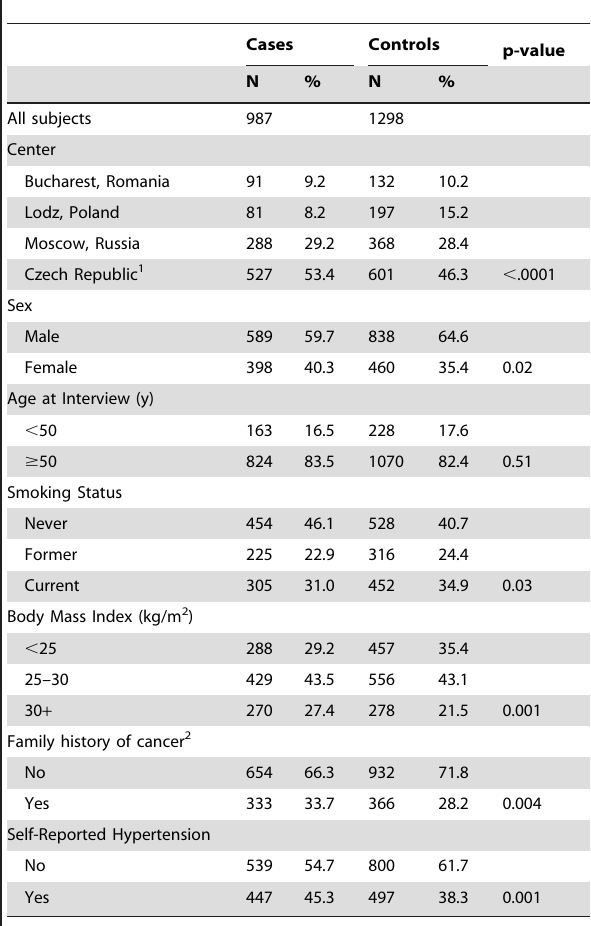
1 Four centers: Brno, Olomuc, Prague, and Ceske. 2 First degree relative with any cancer. doi:10.1371/journal.pone.0004895.t002 PLoS ONE |